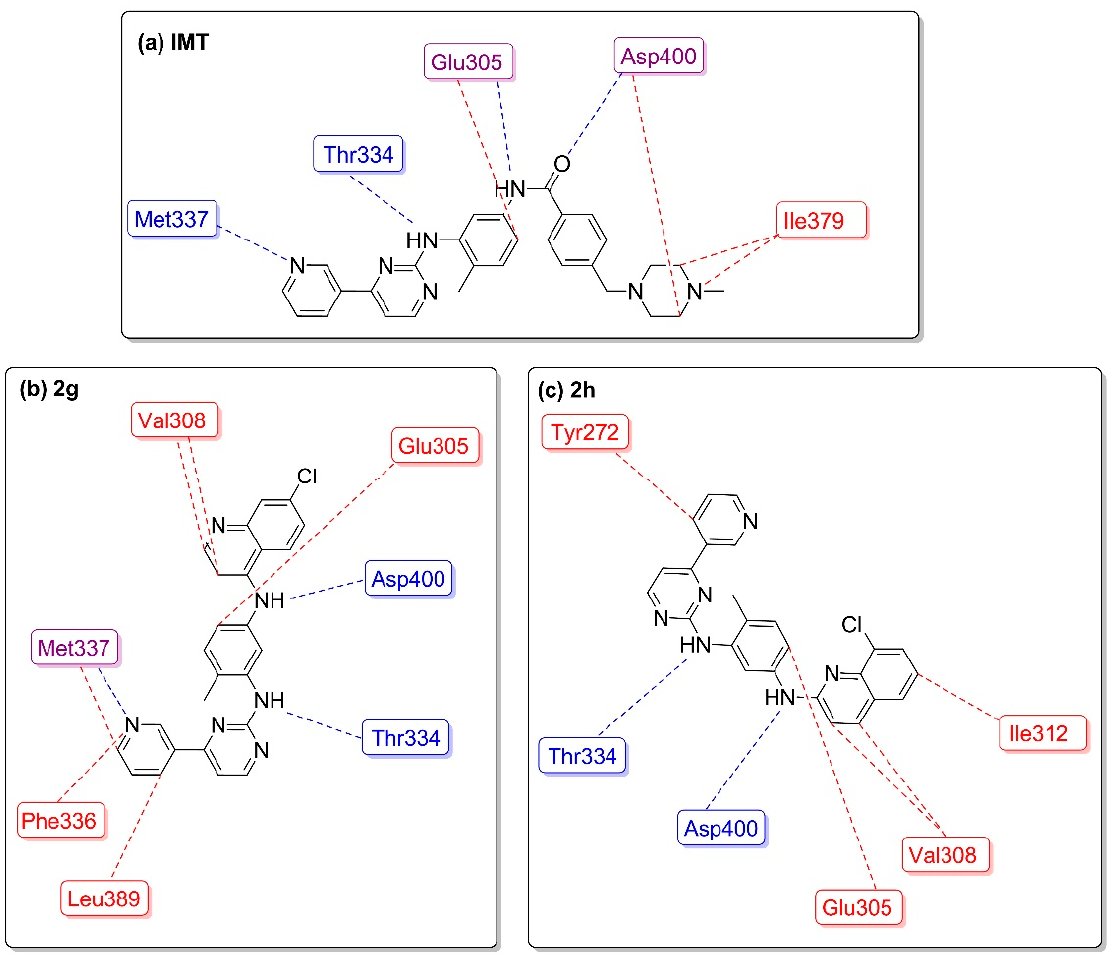
Figure 6. Interaction maps of inhibitors IMT ( a ), 2g ( b ), and 2h ( c ) with the BCR-ABL1 structure (PDB code: 3PYY), showing steric interactions (red dotted lines) and hydrogen bonds (blue dotted lines).